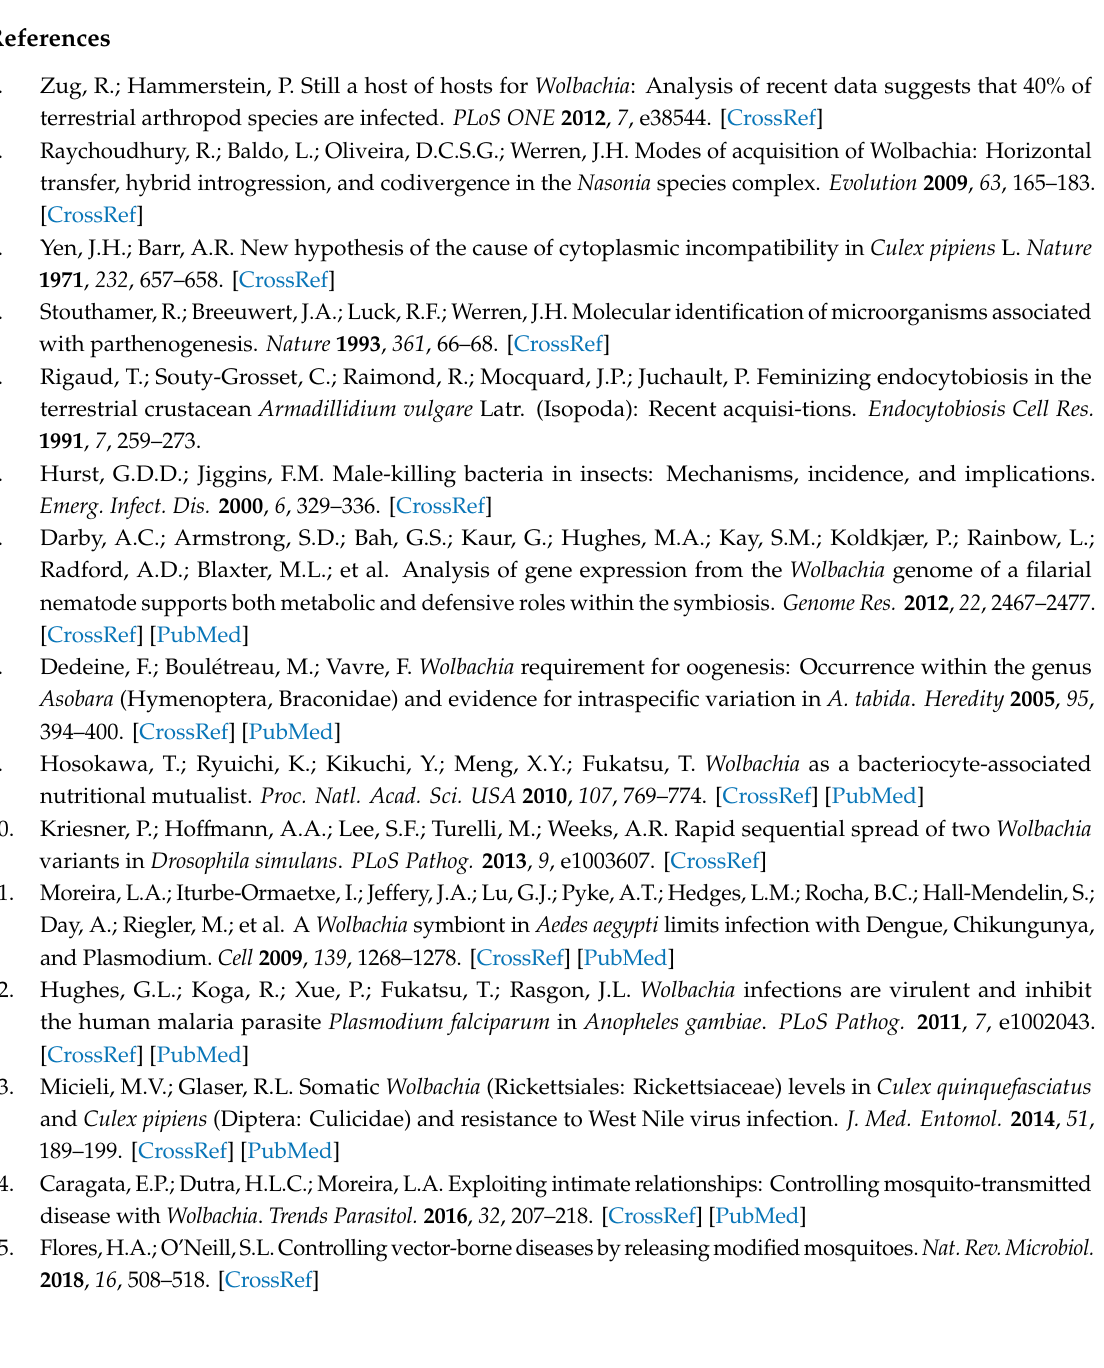
Table S1: Accession number of various host lines used in this